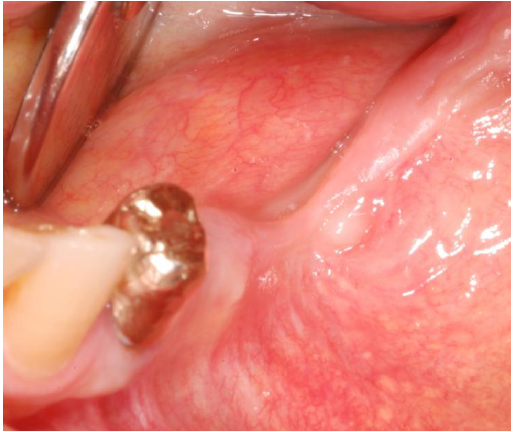
Figure 5. The 3-month postoperative healing of the soft tissue without bone exposure on the left side.